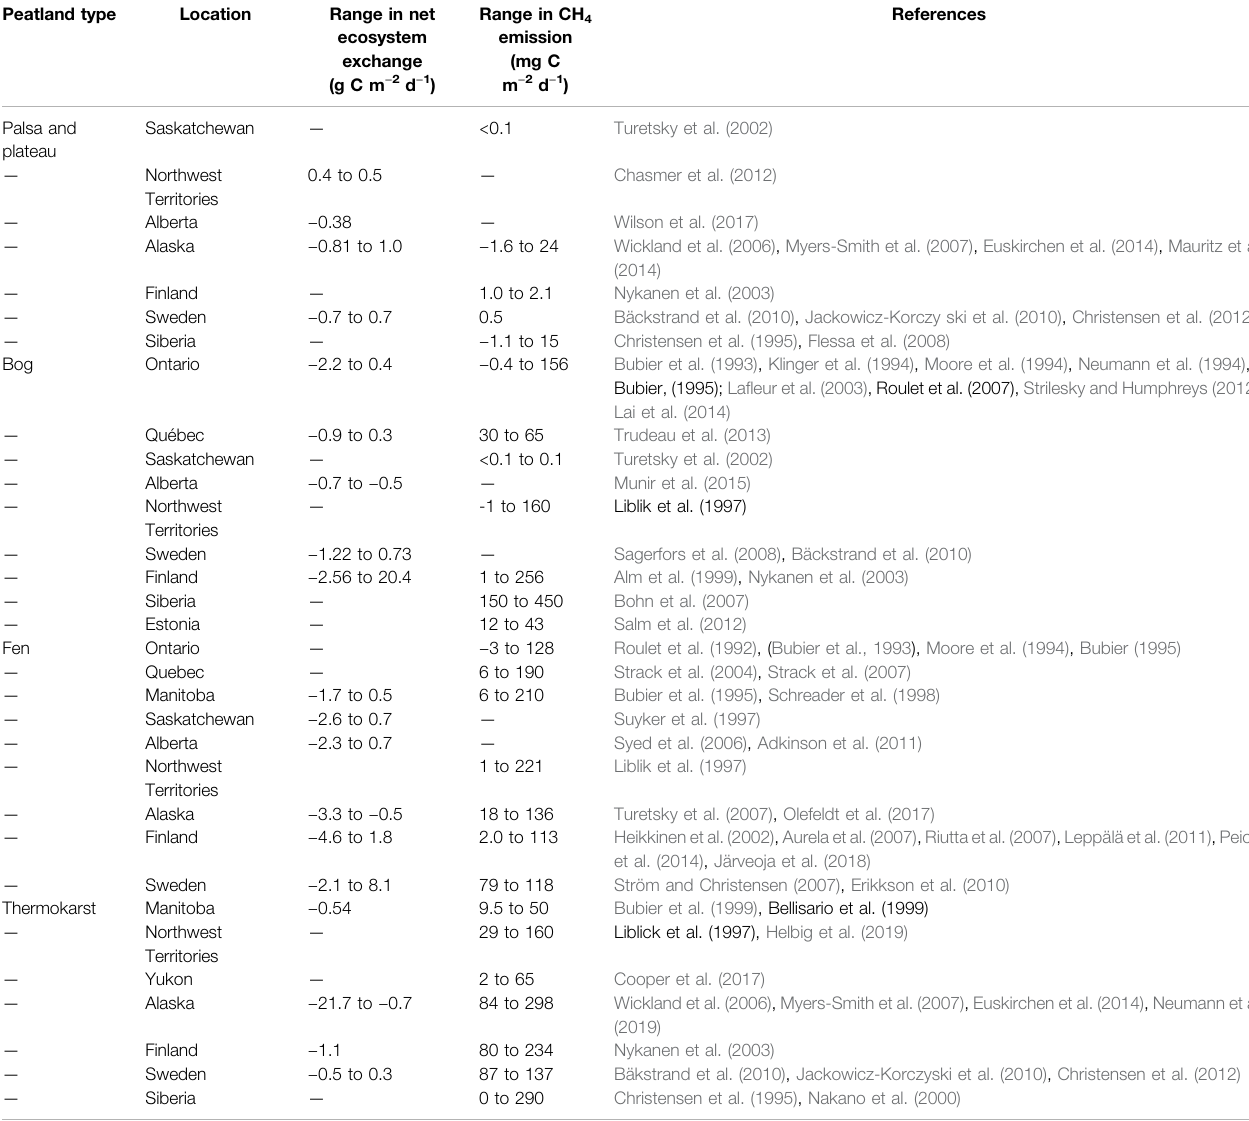
TABLE 1 | Range in data for net ecosystem exchange and methane (CH 4 ) emissions for peatlands north of 45 ⁰ latitude. Peatland